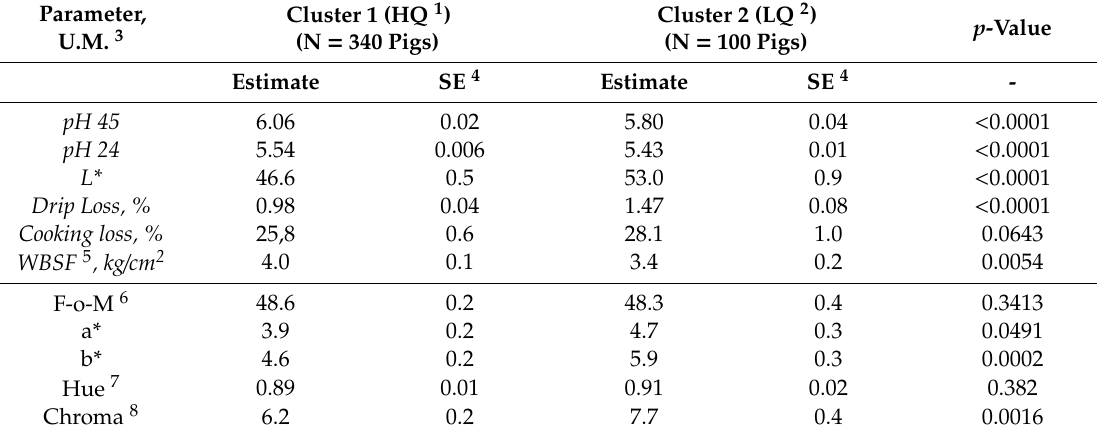
Figure 1. Three-dimensional representation of the shipments clustered according to meat quality parameters (pH 45, pH 24, L*, Drip Loss, Cooking Loss and WBSF) and seen from di ff erent angles ( a ) and ( b ). Each dot on the graph represents a shipment. Cluster 1 (red color, 34 shipments), Cluster 2 (green color, 10 shipments). The colored area represents the area around the cluster centroid. Table 1. Summary of the meat quality characteristics of the two clusters. Variables in italics were used for data